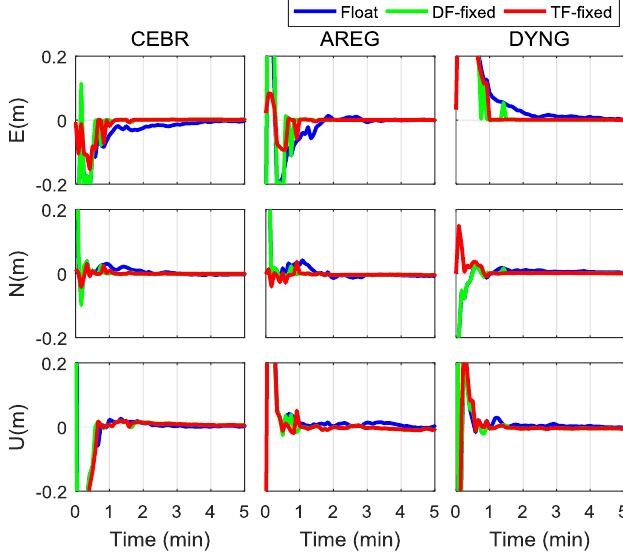
Figure 11. LEO-only PPP float and fixed solutions at stations AREG, CEBR, and RGDG from 20:00 to 20:05 on January 1, 2017.